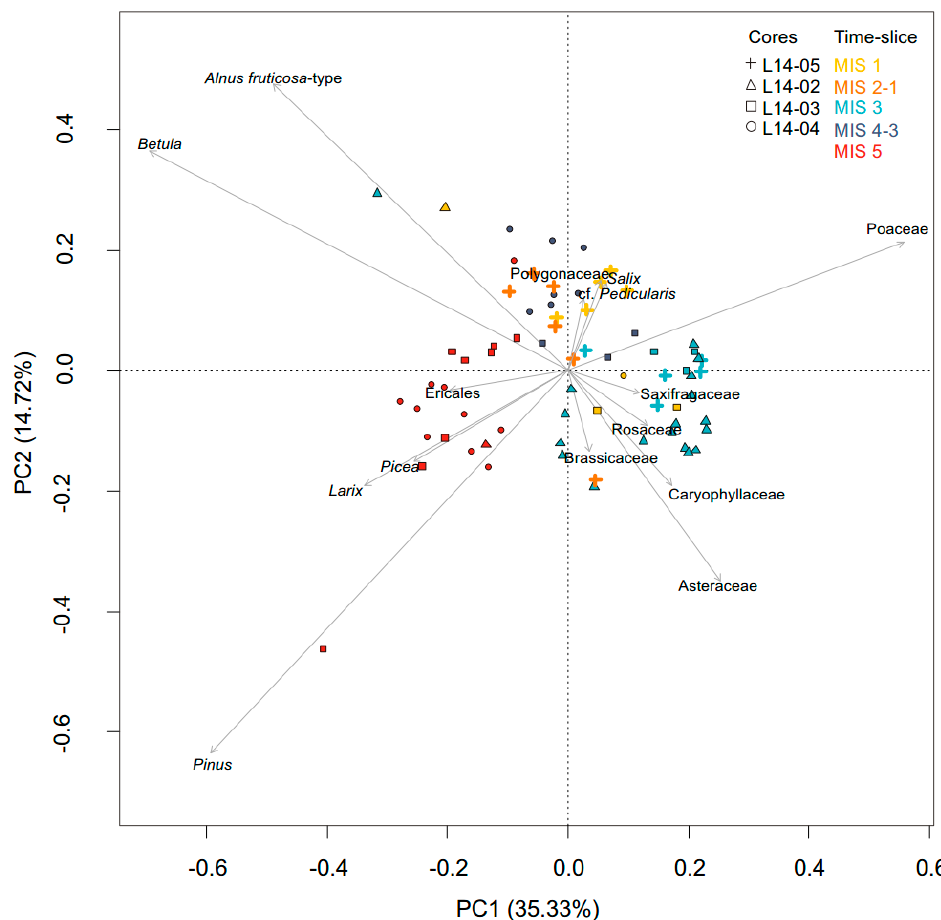
Figure 7. PCA biplot comprising the 15 principal terrestrial pollen taxa (with trees and shrubs pooled to genus level and with herbs and non ‐ erect dwarf ‐ shrubs pooled to family level) and samples. Samples are coloured according to the corresponding marine isotope stage (MIS 1 in yellow, MIS 2 to MIS 1 transition in orange, MIS 3 in light blue, MIS 4 to MIS 3 in dark blue and MIS 5 in red) and the different symbols indicate the core from which the samples were taken (L14–05 with a cross, L14 ‐ 02 a triangle, L14–03 a quadrate and L14–04 a